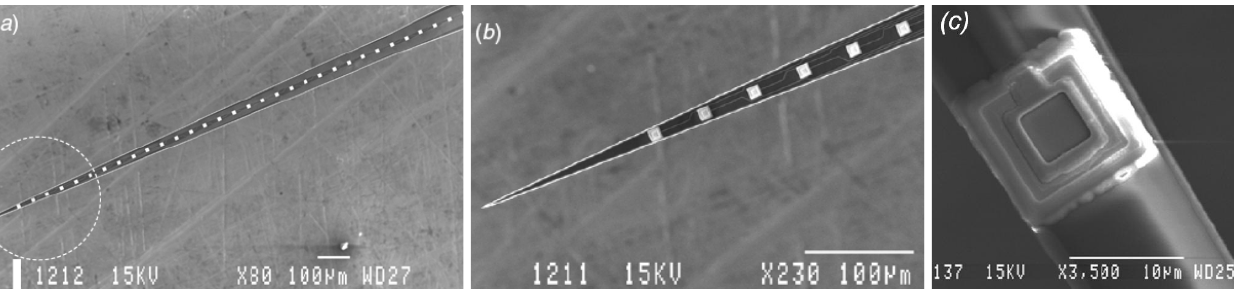
Figure 9. Scanning electron micrograph of: (a) A silicon probe with 1 shaft x 32 electrodes. (b) Close-up of a probe tip designed with 4 o taper angle. The interconnect lines shown are 1µm wide. (c) Close-up of a 10 µm x 10 µm Ir electrode site. Reprinted from [102], with permission from Institute of Physics Publishing.